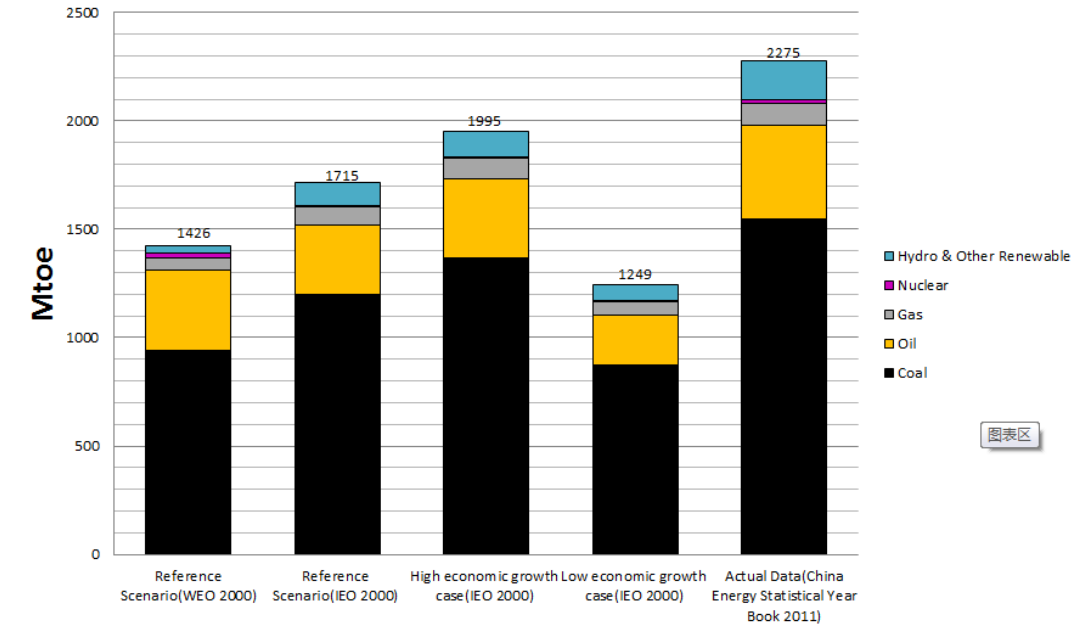
Figure 2. Projection and actual primary energy consumption of China in